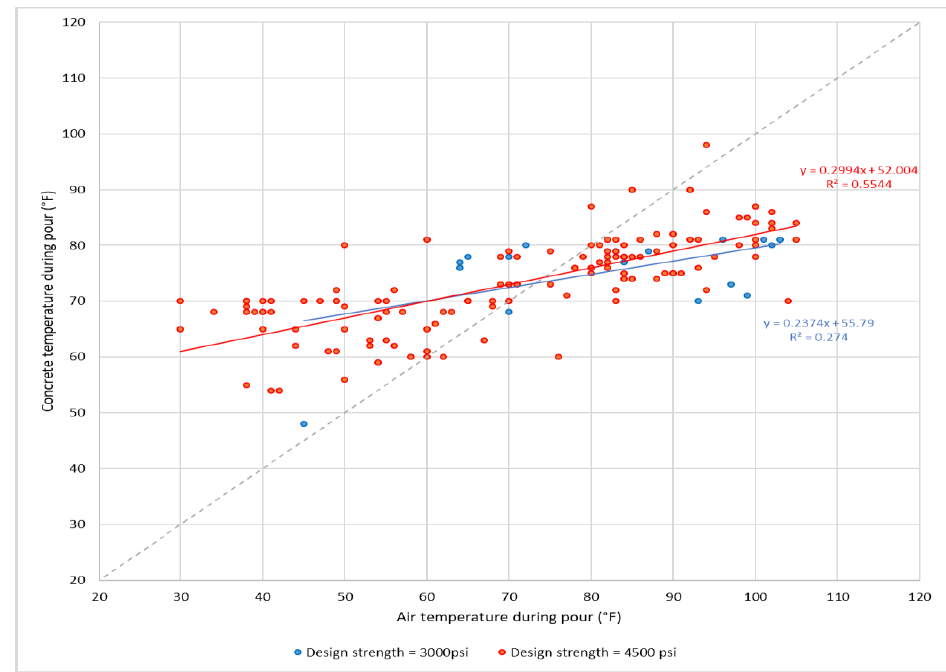
Figure 9. The relationship between concrete temperature and air temperature with respect to design strength (linear regression).